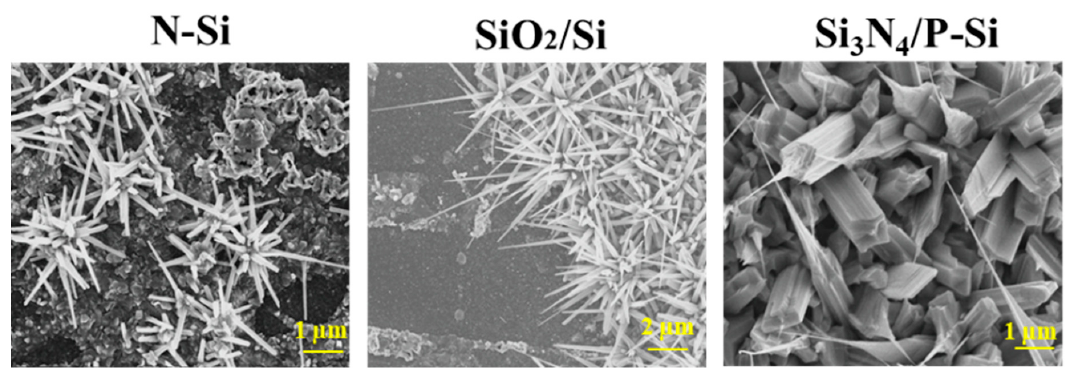
Figure 3. SEM images of different Ga 2 O 3 nanostructures grown on different substrates: N-Si, SiO 2 /Si and Si 3 N 4 /P-Si.